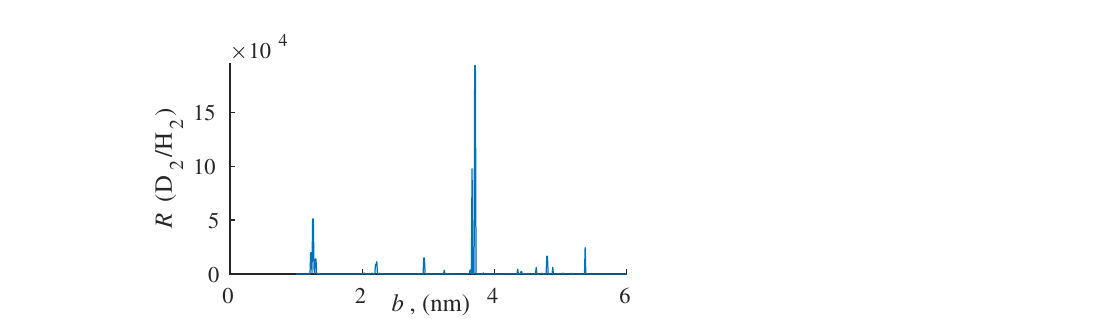
Figure 3. The dependence of the degree of separation R on the distance between the membrane layers b for hydrogen isotopes, T = 45.1 K.